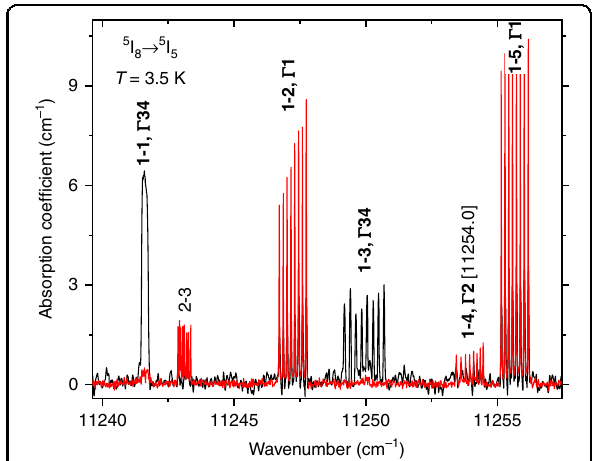
Fig. 2 5 I 5 CF levels with resolved HFS. The π - ( k ⊥ c , E|| c ; black trace) and σ - ( k ⊥ c , E ⊥ c ; red trace) polarized absorption spectra of a LiYF 4 :Ho 3 + (0.1 at. %) single crystal at the temperature 3.5 K in zero magnetic fi eld. δσ = 1/2 L = 0.01 cm − 1 ( L is the maximal displacement of a moving mirror in the Fourier